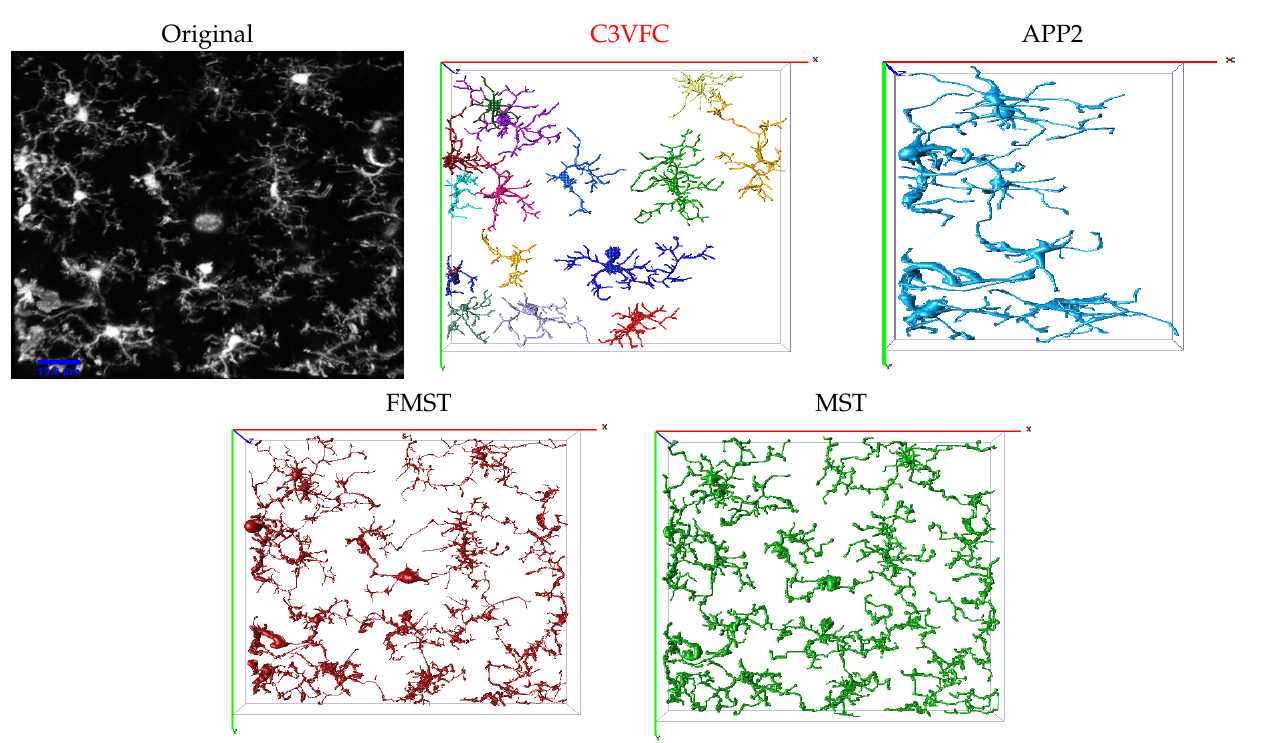
Figure 6. Visual comparison of the multi-cellular reconstruction results using C3VFC (our method), APP2, FMST, and MST. Separated cells are distinguished by color for the result of every